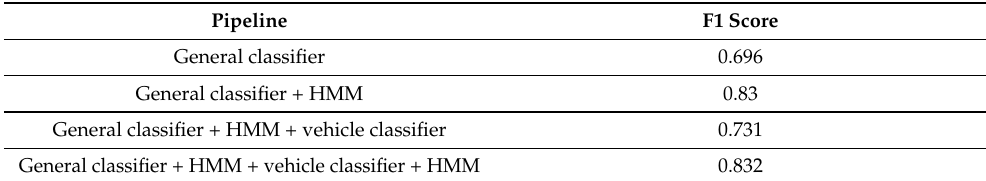
Table 9. The F1 scores obtained at different stages of a pipeline that uses a vehicle-specific model and HMMs. The pipeline utilizes data from the 2019 SHL